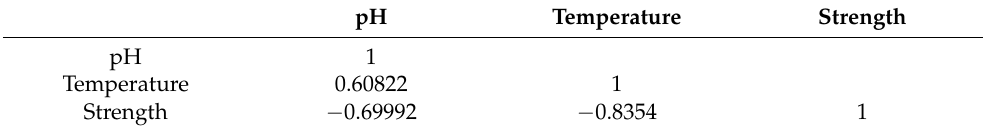
Table 9. Correlation analysis results (pH =